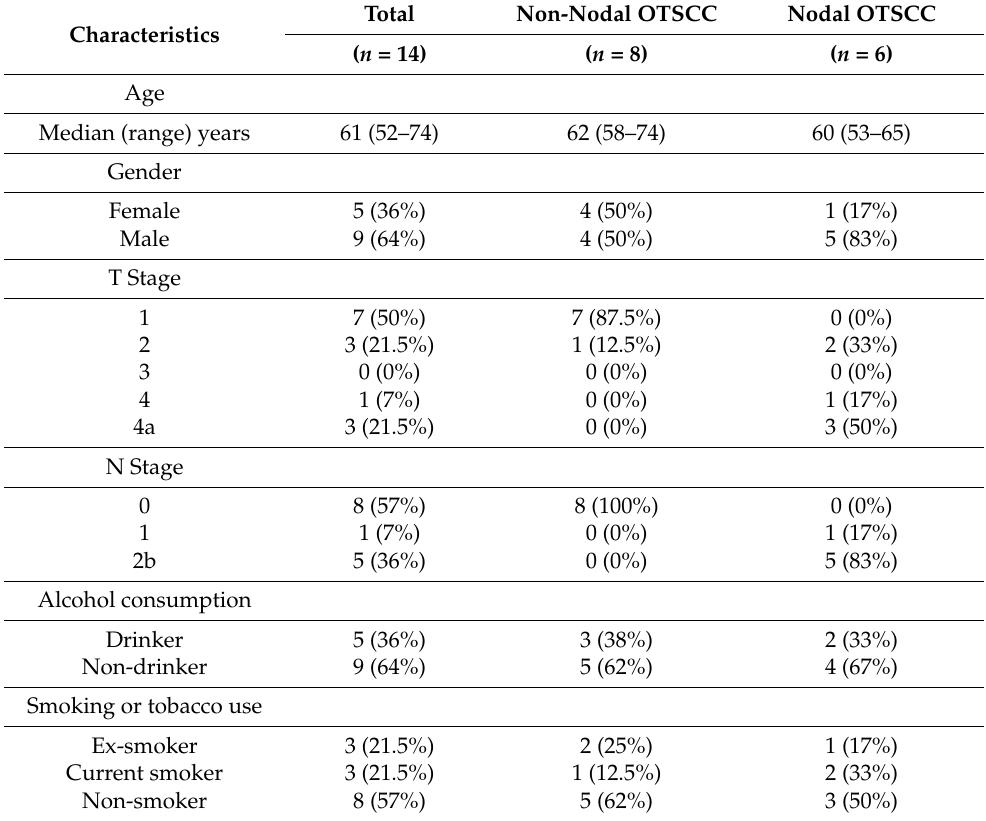
Table 1. Patient and tumor